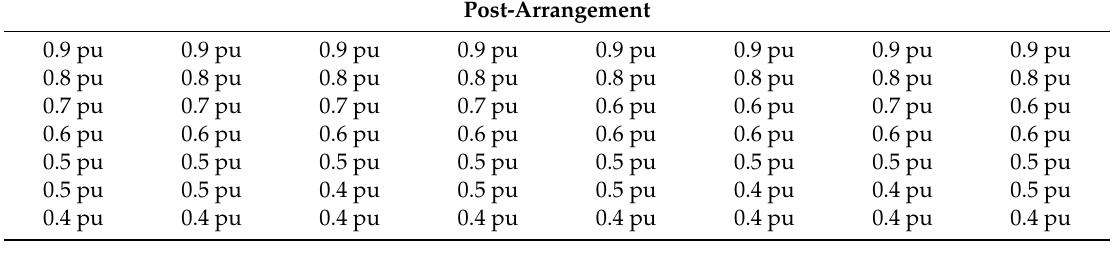
Table 6. PV array 5 × 8 parameters Pre and Post-arrangement.